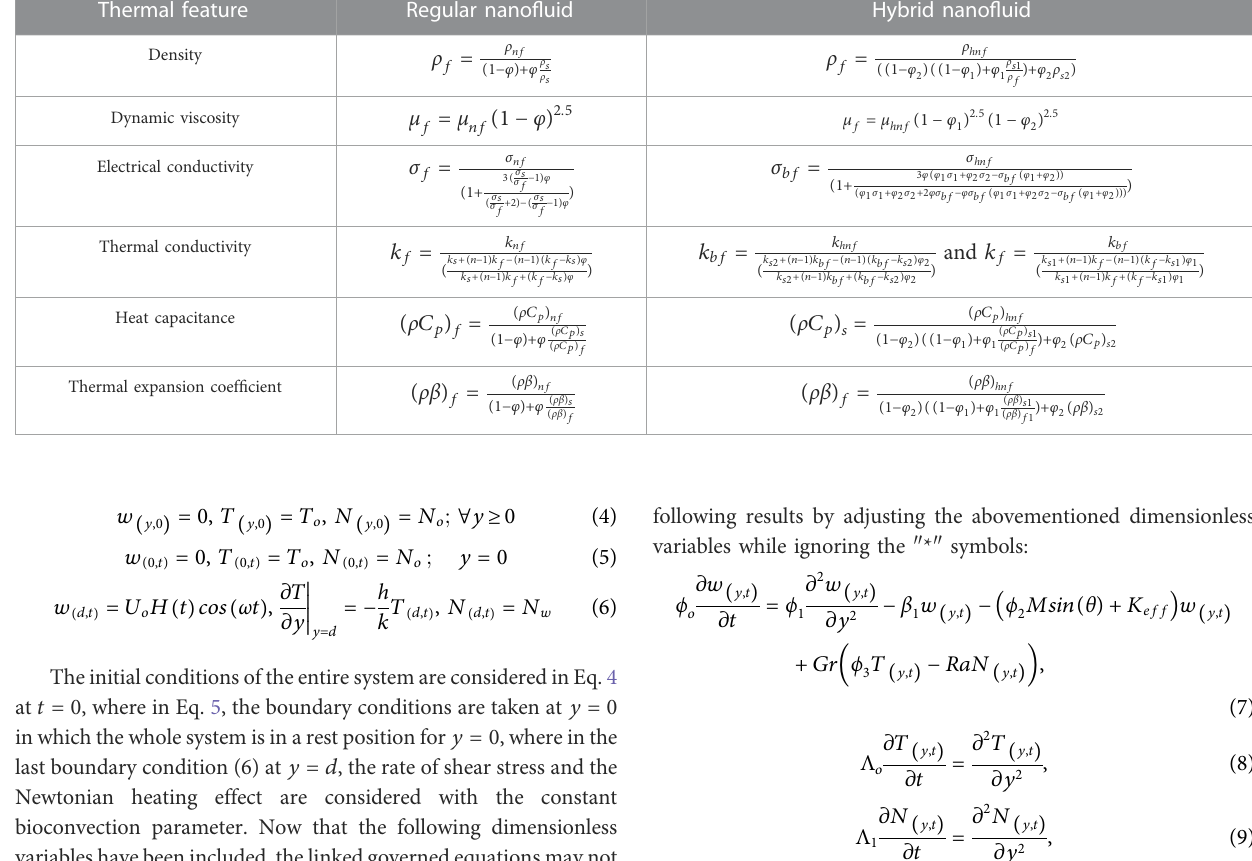
TABLE 1 Quantities of hybrid nano fl uids ’ thermophysical properties. Thermal feature Regular nano fl